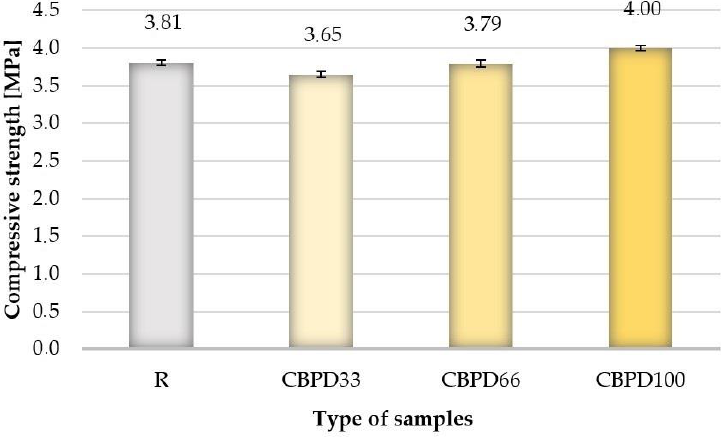
Figure 4. Compressive strength